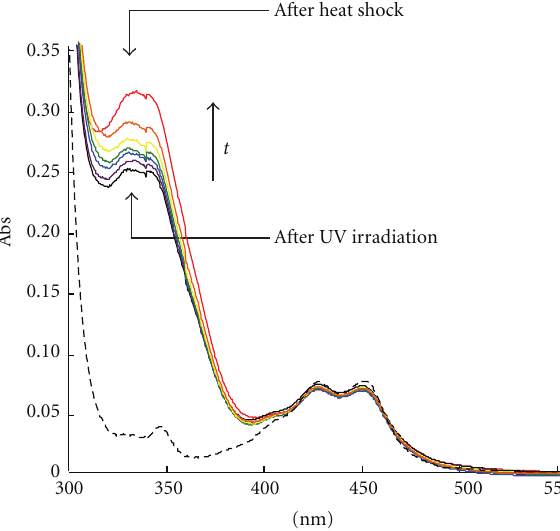
Figure 3: Time dependence of UV-VIS absorption of 1 / 2 complex. The spectra were measured 0 (black), 1 (purple), 6 (blue), 11 (green), 16 (yellow), and 21h (orange) after UV irradiation at pH 7.5 and 37 ◦ C. The spectrum after heat shock ( trans -dominant) is drawn in red. The dashed line represents the spectrum of 1 / 3 com- plex without azobenzene. Table 1: MALDI-TOF/MS analyses of the conjugates. Calcd. m/z [M + H]